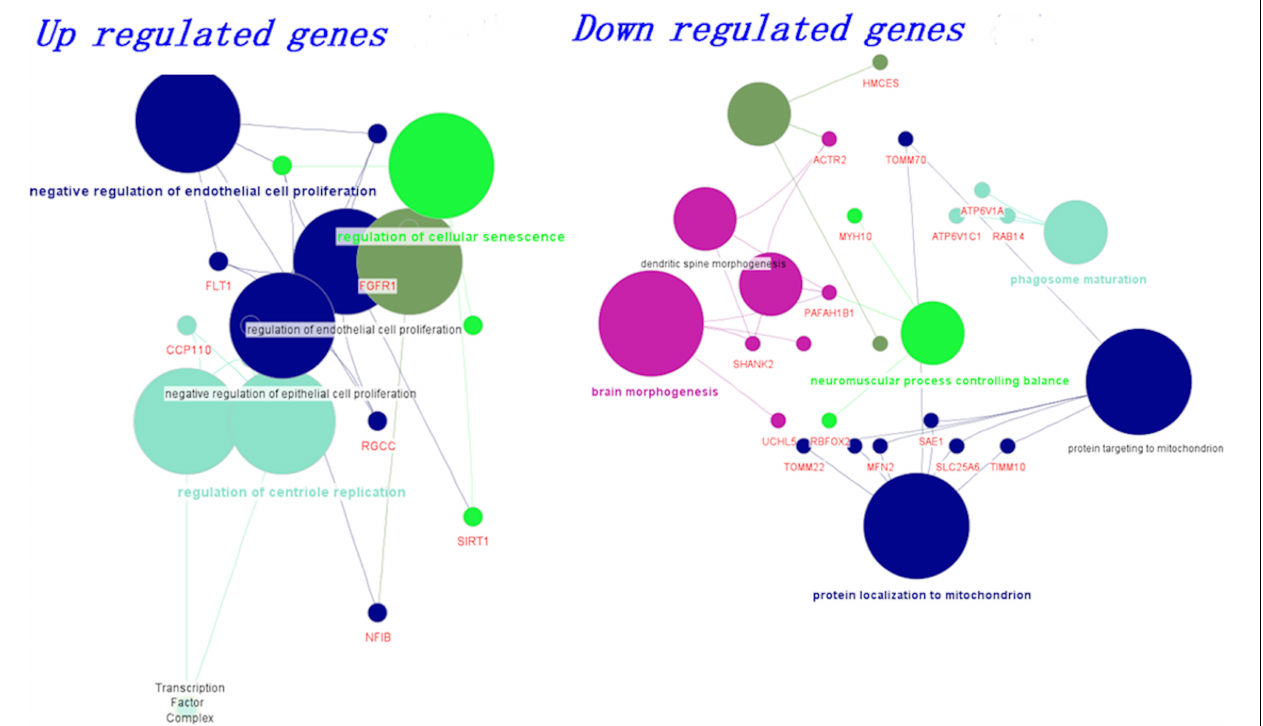
FIGURE 2 | Biological classification and functional enrichment modules for upregulated and downregulated genes in AD and PD pathogenesis. Modules are shown in different colors and the size of the node denotes the number of genes.